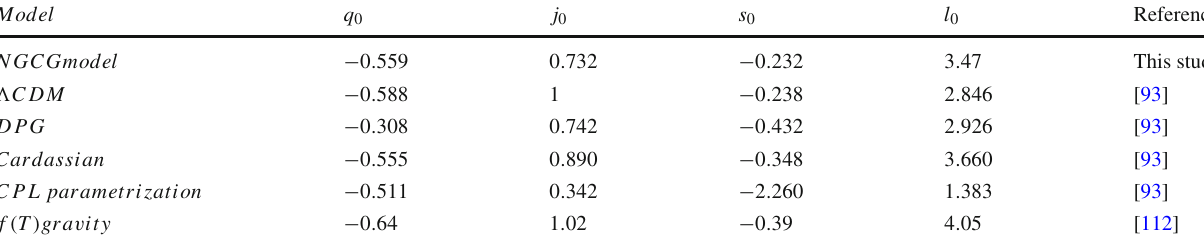
Fig. 6 The evolution of cosmographic parameters for best fitted parameters and initial conditions Table 1 Comparison of current values of cosmographical for different models Model q 0 j 0 s 0 l